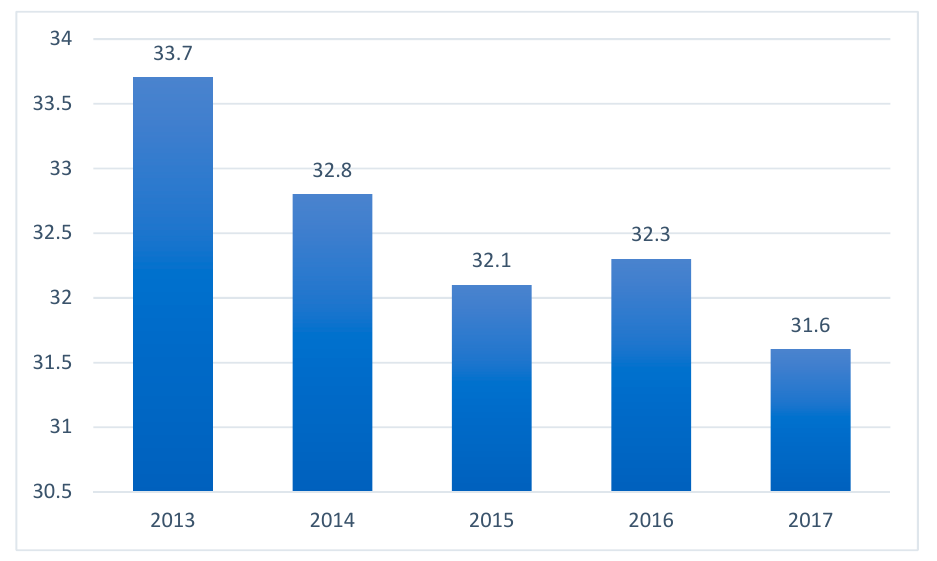
Figure 3. Change in the coverage of youth aged 17–25 years with higher education programs, in %. Source: Analytical Center for the Government of the Russian Federation (2018).